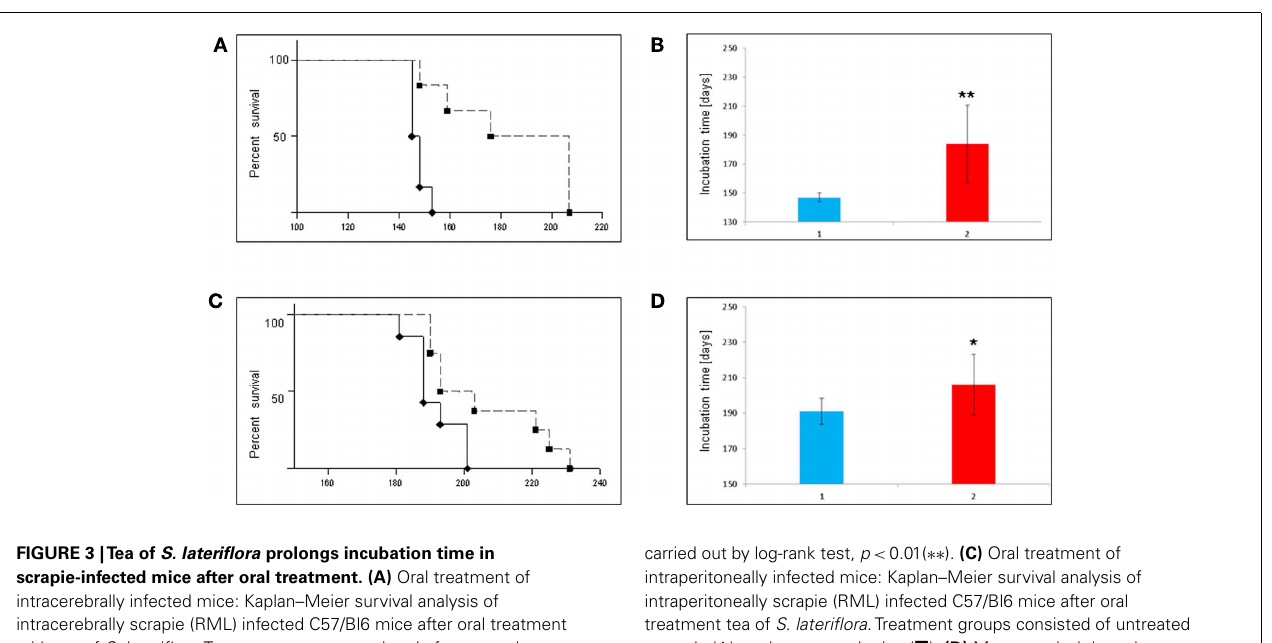
FIGURE 3 |Tea of S. lateriflora prolongs incubation time in scrapie-infected mice after oral treatment. (A) Oral treatment of intracerebrally infected mice: Kaplan–Meier survival analysis of intracerebrally scrapie (RML) infected C57/Bl6 mice after oral treatment with tea of S. lateriflora. Treatment groups consisted of untreated controls ( (cid:2) ), and tea treated mice ( (cid:3) ). (B) Mean survival times in primary efficiency test ± SD. Comparison of tea versus untreated controls was